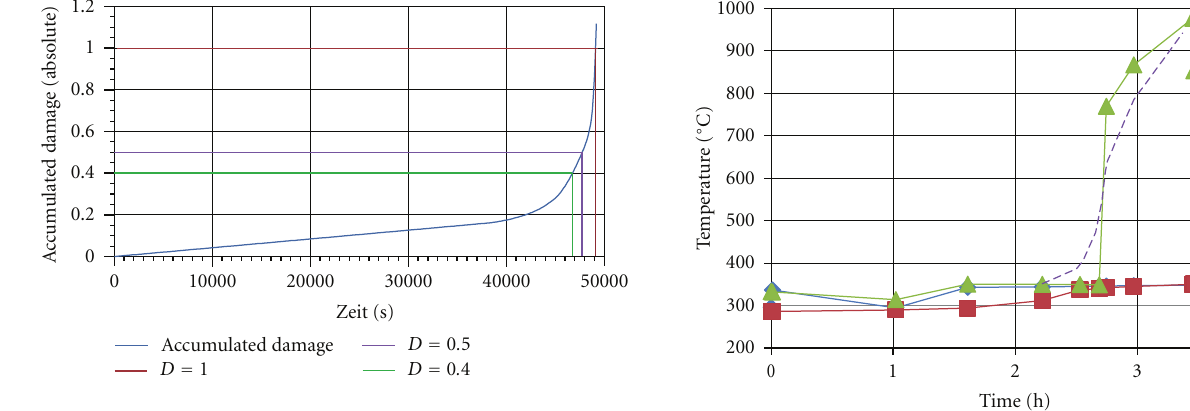
Figure 12: Summation of damage increments (ASTOR).